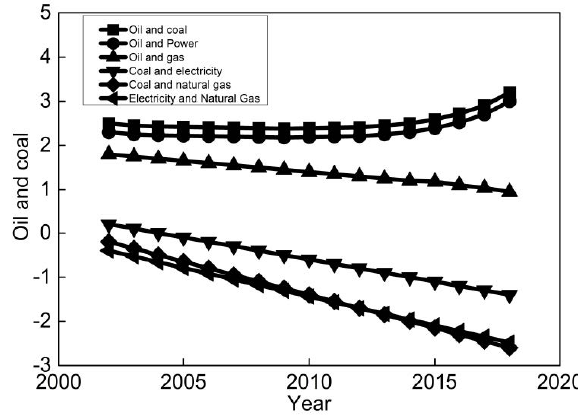
Fig. 7 Differences in technological progress of different energy